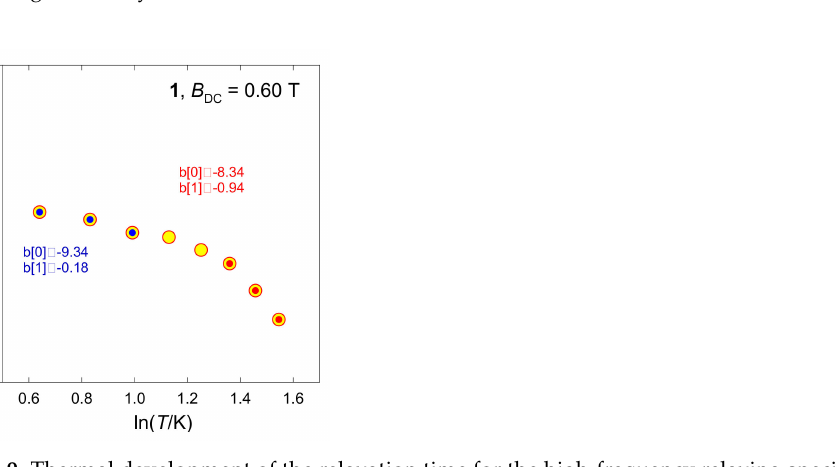
Figure 8. Fitted AC susceptibility data for 1 : Argand diagram ( left ) and Arrhenius-like plot ( right ). Lines are guide for eyes.